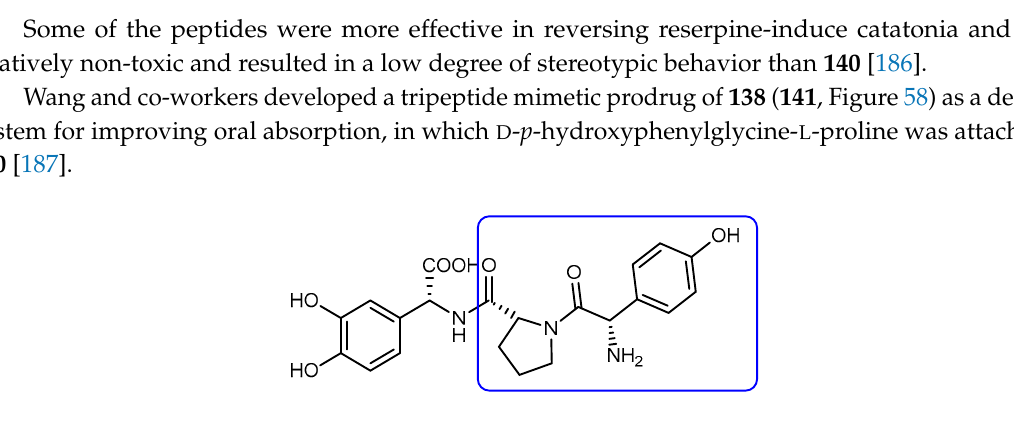
Figure 57. Di- and tripeptides prodrugs of 140 .